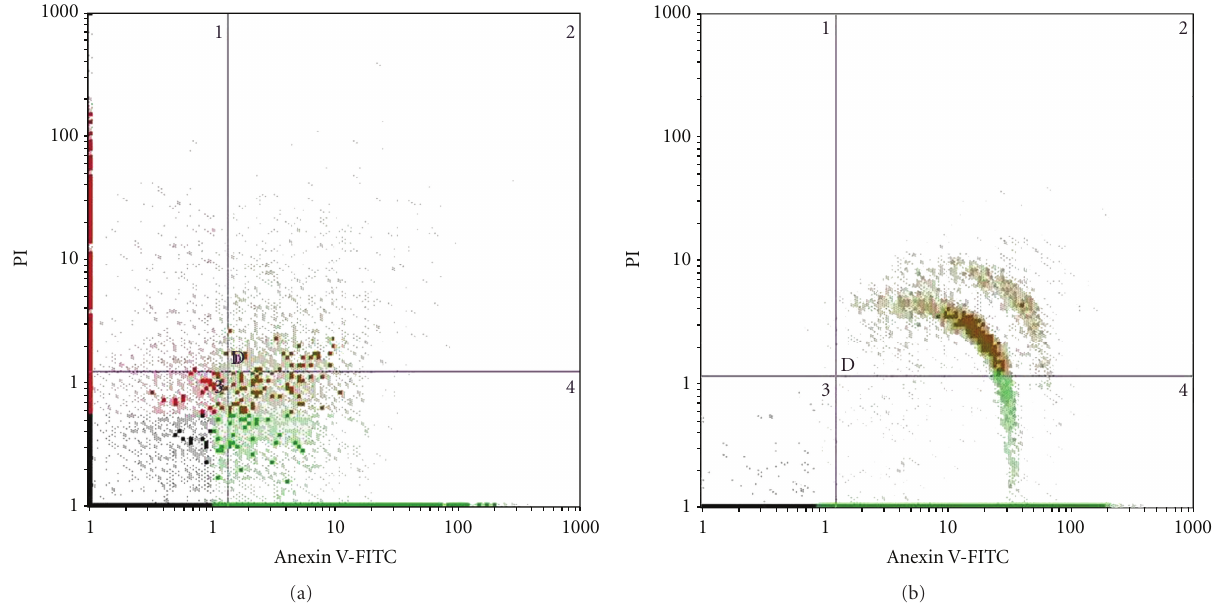
Figure 3: The FCM analyses following staining with annexin V-FITC and PI show the induction of apoptosis in IECs. Background labeling of living cells is found in quadrant 3, whereas quadrant 4 contains apoptotic cells, stained with annexin V-FITC only, and quadrant 2 represents cells that bind to annexin V and PI and is considered to be in late stages of apoptosis, exhibiting disrupted cell membrane or necrosis. Compared with cells in control group, the percentage of apoptotic cells increased in injury group. After treatment with verapamil, the percentage of apoptotic cells decreased compared with that in injury group.